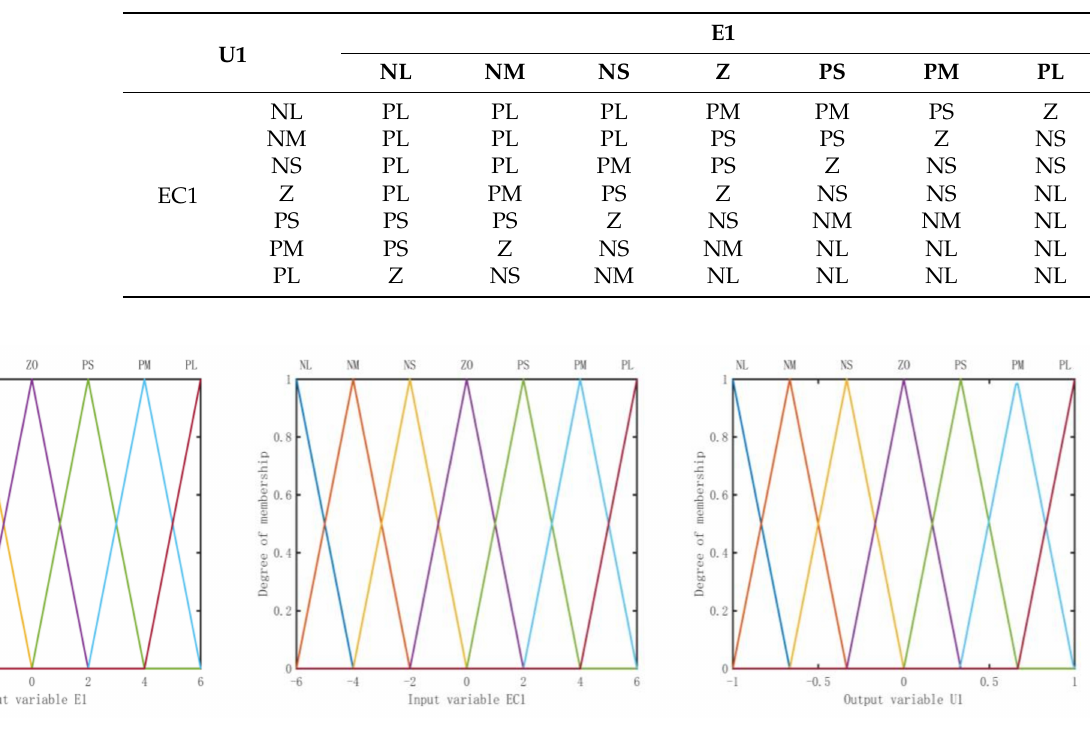
Table 4. Fuzzy rules of the yaw rate and sideslip angle fuzzy feedback controller.